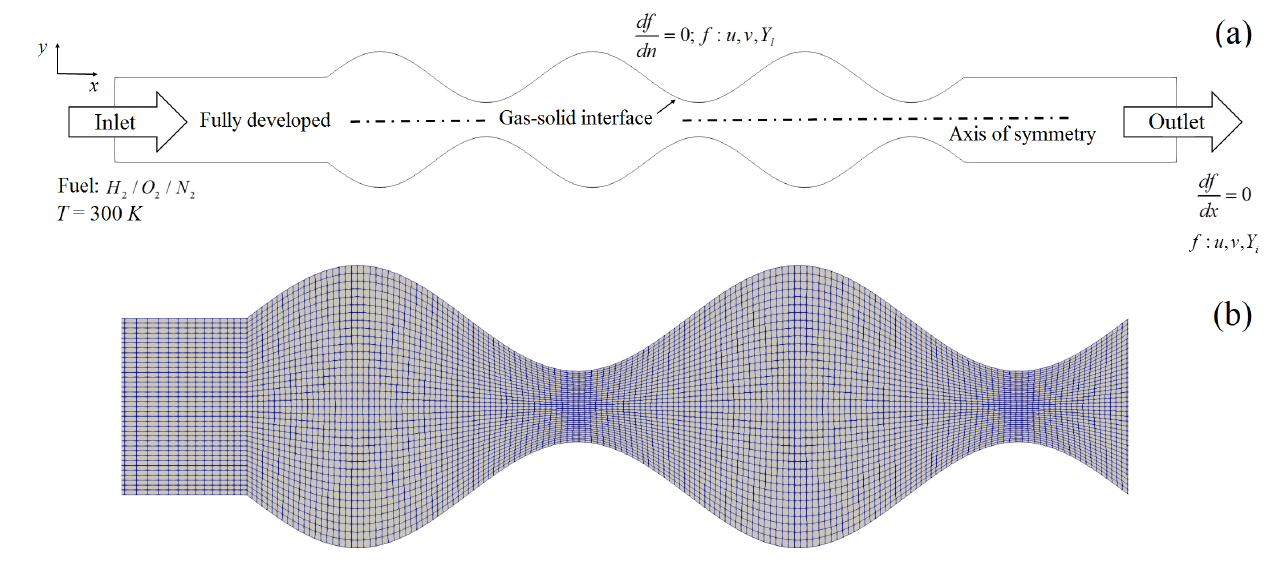
Figure 2. Schematic illustration of the ( a ) undulated geometry and ( b ) mesh resolution.